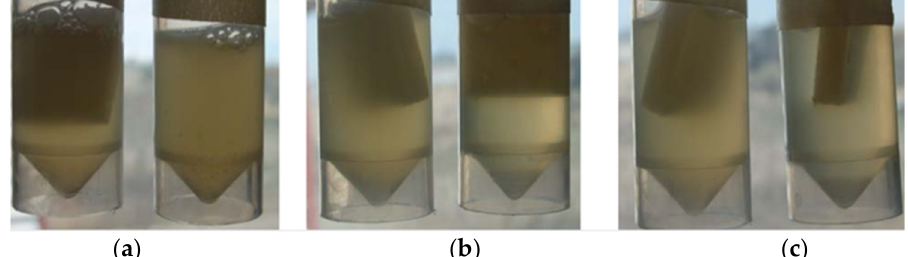
Figure 5. Macroscopic appearance of the tubes with P. putida after 24 h incubation at 30 °C, where ( a ) control sample of the pad with water (on the left) and without pad (on the right); ( b ) control sample of the pad (on the left) and pad with 1 spray of LAE (on the right); ( c ) control sample of the pad (on the left) and pad with 2 sprays of LAE (on the right).